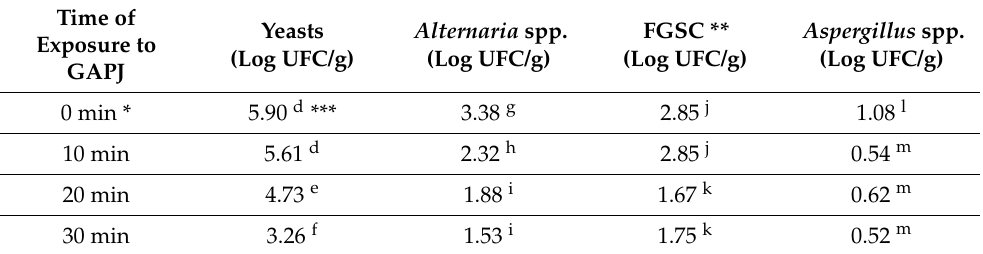
Table 2. Mean Log CFU/g (five samples/treatment) of fungi isolated from barley grains not treated and treated during 10, 20, and 30 min with GAPJ. Time of Alternaria spp. Aspergillus spp. Yeasts FGSC ** Exposure to (Log UFC/g) (Log UFC/g) (Log UFC/g) (Log UFC/g) GAPJ 0 min * 5.90 d *** 3.38 g 2.85 j 1.08 l 10 min 5.61 d 2.32 h 2.85 j 0.54 m 20 min 4.73 e 1.88 i 1.67 k 0.62 m 30 min 3.26 f 1.53 i 1.75 k 0.52